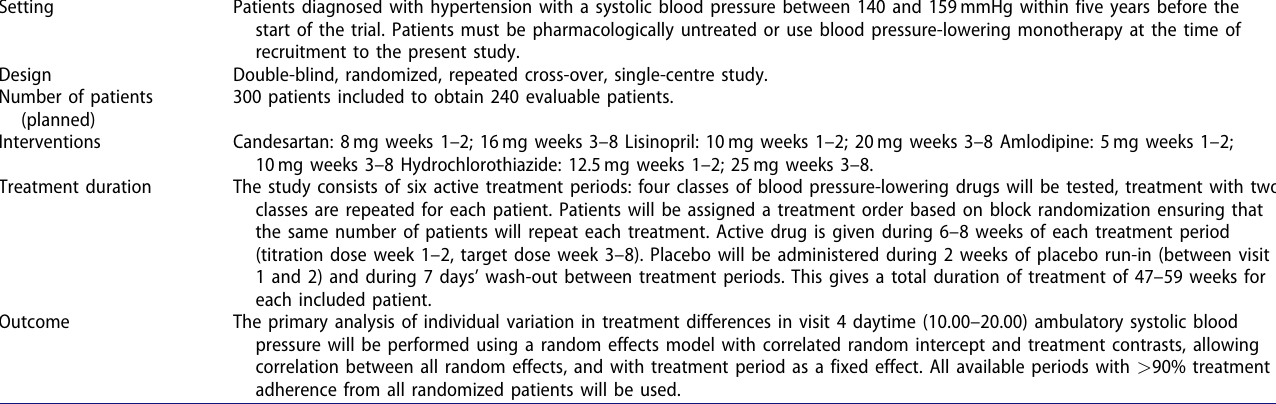
Table 1. Study outline.